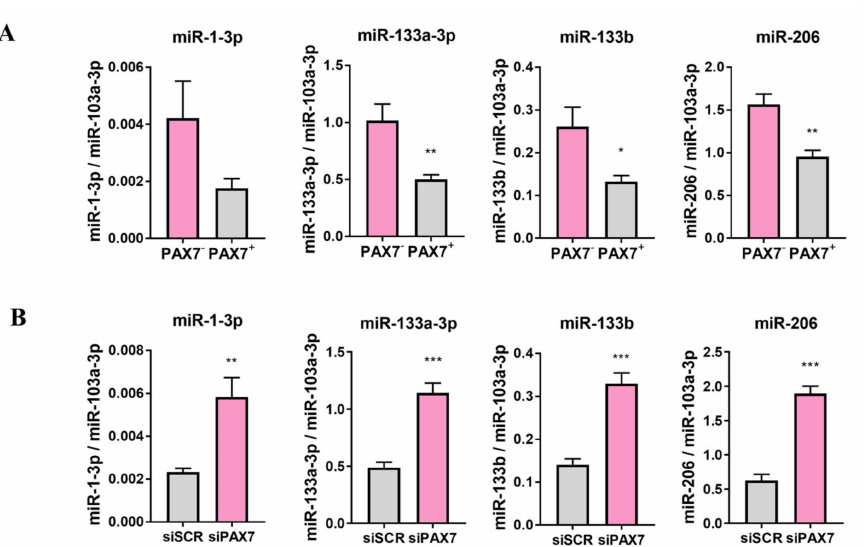
Figure 6. PAX7 transcription factor regulated expression levels of myogenic microRNAs in RH30 cells. ( A ) miR-1-3p, miR-133a-3p, miR-133b, and miR-206 expression levels were increased in RH30 PAX7 − subclone compared to RH30 PAX7 + subclone. ( B ) PAX7 silencing with siRNA in RH30 PAX7 + subclone upregulated miR-1-3p, miR-133a-3p, miR-133b, and miR-206 expression levels. miRNA expression levels were evaluated with qPCR, n = 3. Data were calculated with 2 − ∆ Ct method using miR-103a-3p as constitutive genes. The data on graphs show means ± SEM. * p < 0.05, ** p < 0.01, *** p <